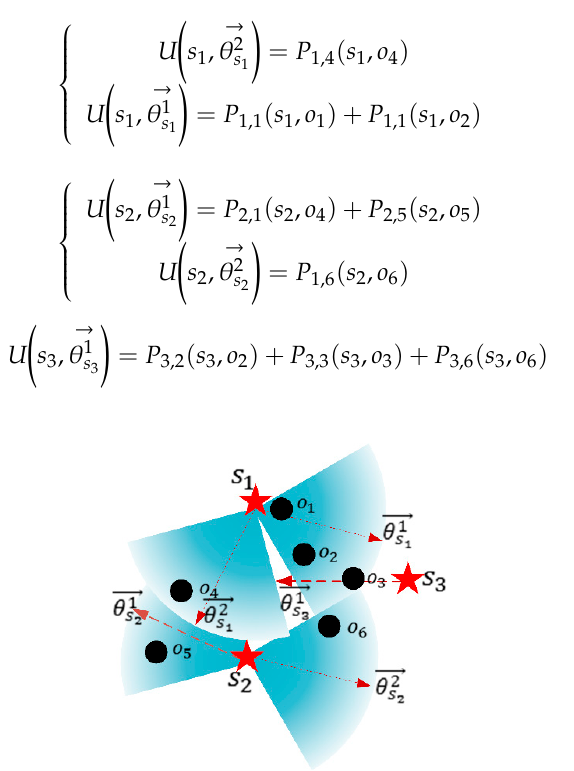
Figure 6. Combination of candidate docking spots and orientations.